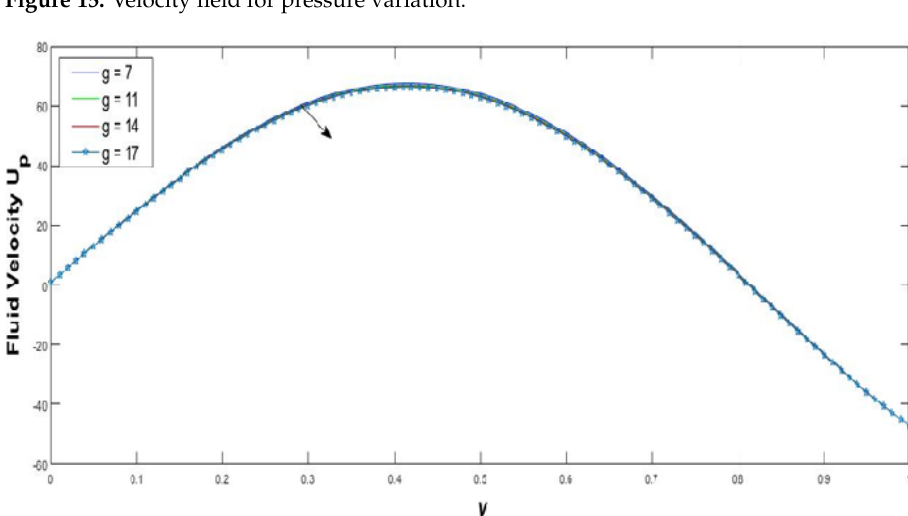
Figure 15. Velocity field for pressure variation.